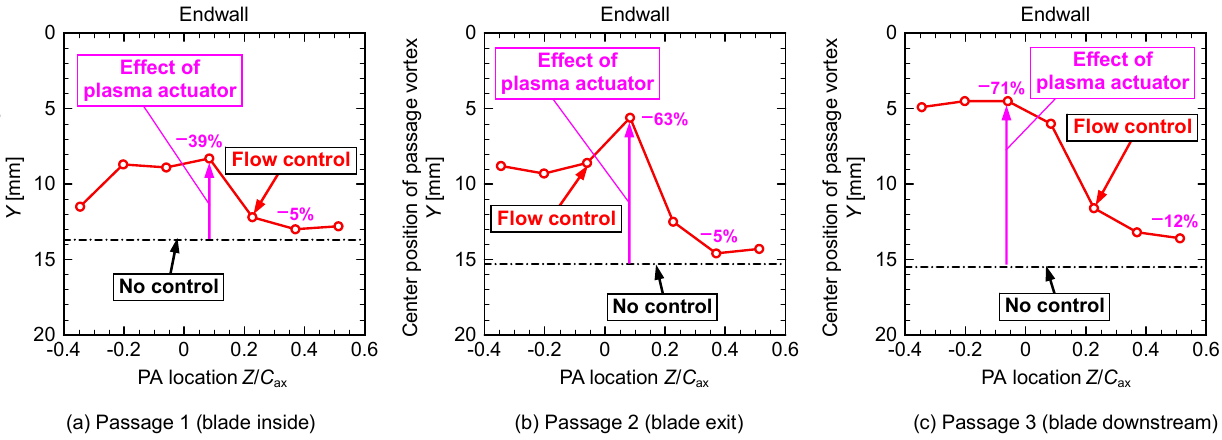
Figure 11. Effect of the plasma actuator location on the center position of the passage vortex (Re out = 1.8 × 10 4